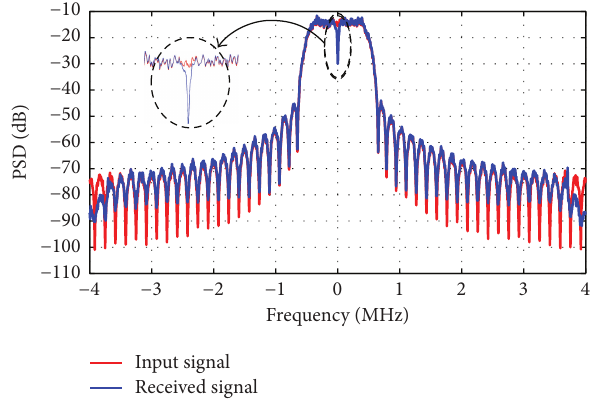
Figure 3: Input and output signal spectrums of a 16-QAM modu- lated signal having 1MHz frequency bandwidth when 𝐼 - 𝑄 demod- ulator is used as a direct conversion receiver (DCR).